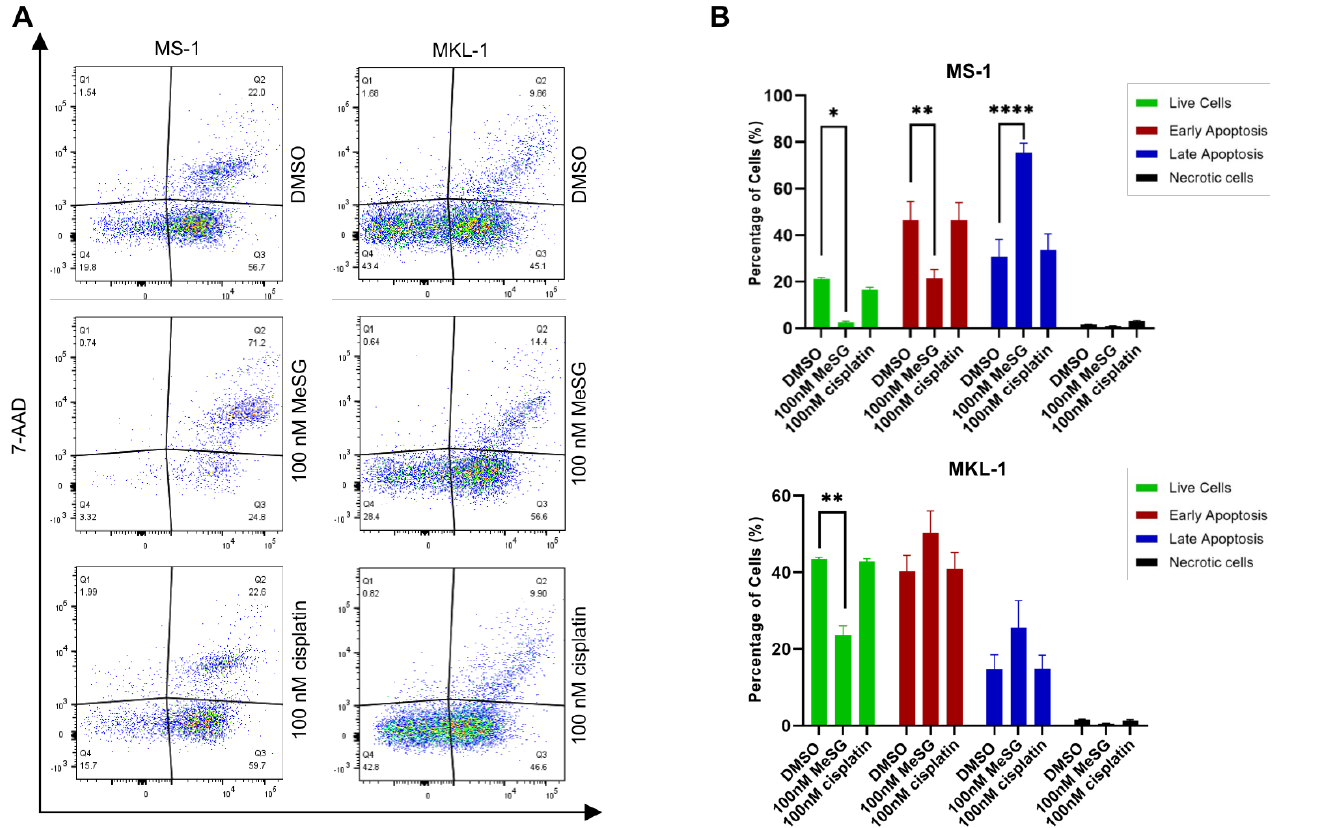
Figure 3. Treatment with MeSG induces cell death of MCC cell lines. ( A ) MeSG is more potent than cisplatin in inhibiting the growth of MCC in vitro. MS − 1 and MKL − 1 cells were incubated with 100 nM MeSG or 100 nM cisplatin for 48 h. Cell apoptosis or necrosis was determined by flow cytometry with Annexin V and 7 − AAD staining. MeSG treatment showed higher efficacy in MCCs compared to the same dose (100 nM) of cisplatin treatment. Data are representative of three independent experiments. ( B ) Treatment with MeSG leads to increased late apoptosis in MS − 1 cells. Error bars represent SEM; n = 3. Data was analyzed using GraphPad Prism software (GraphPad Software, Inc., La Jolla, CA, USA). The one-way analysis of variance (ANOVA) was used to determine statistical significance (MS − 1 graph, * p = 0 .0229, ** p = 0.0020, **** p < 0.0001 and MKL − 1 graph, ** p = 0.00119).